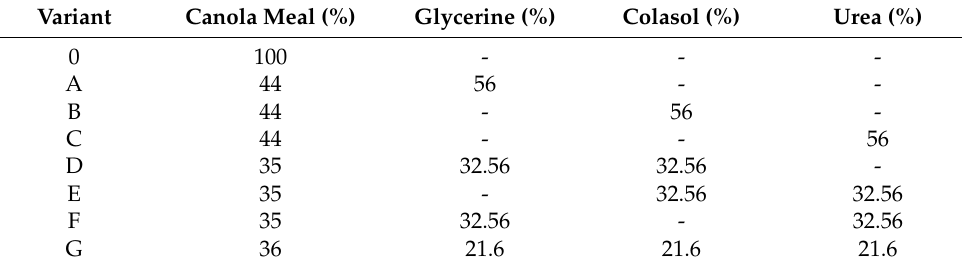
Table 1. Mixing ratios for each of the adhesive formulations.